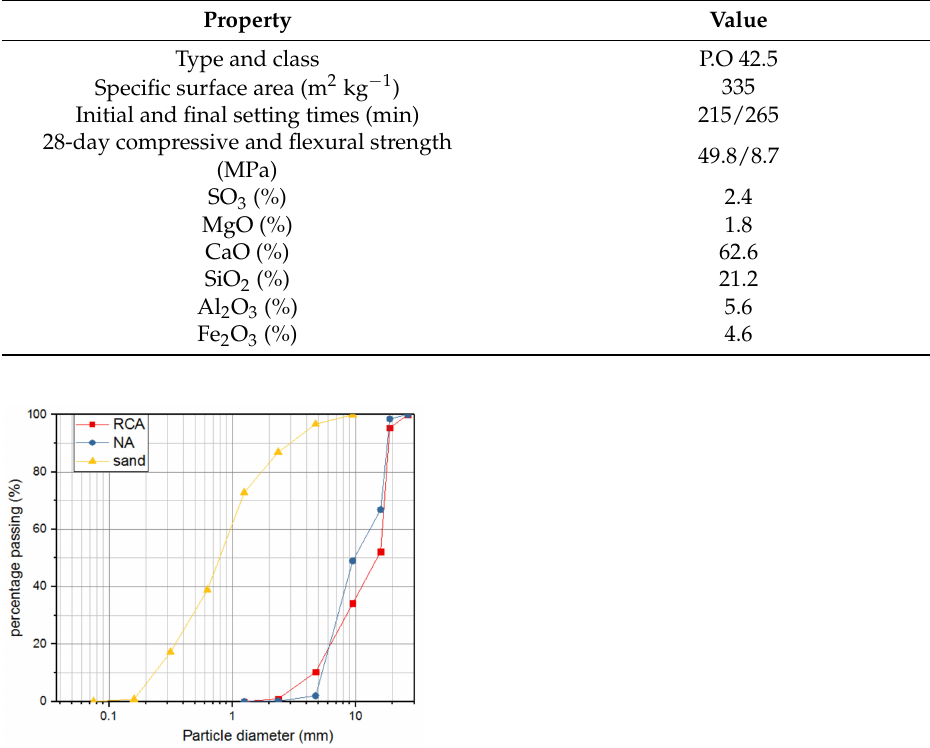
Table 1. Properties of cement.